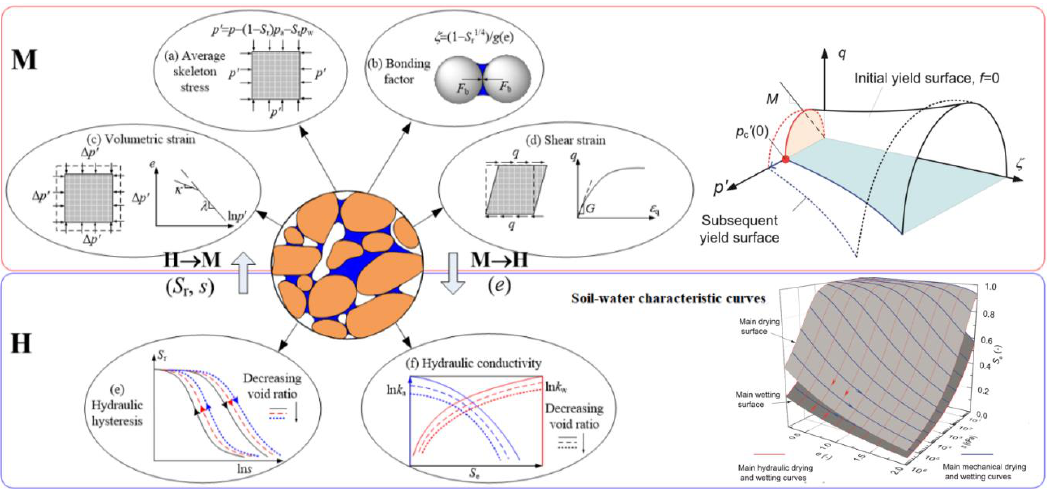
Figure 11. Fully coupling mechanism on elastoplastic deformation and capillary hysteresis of unsaturated soils [66].